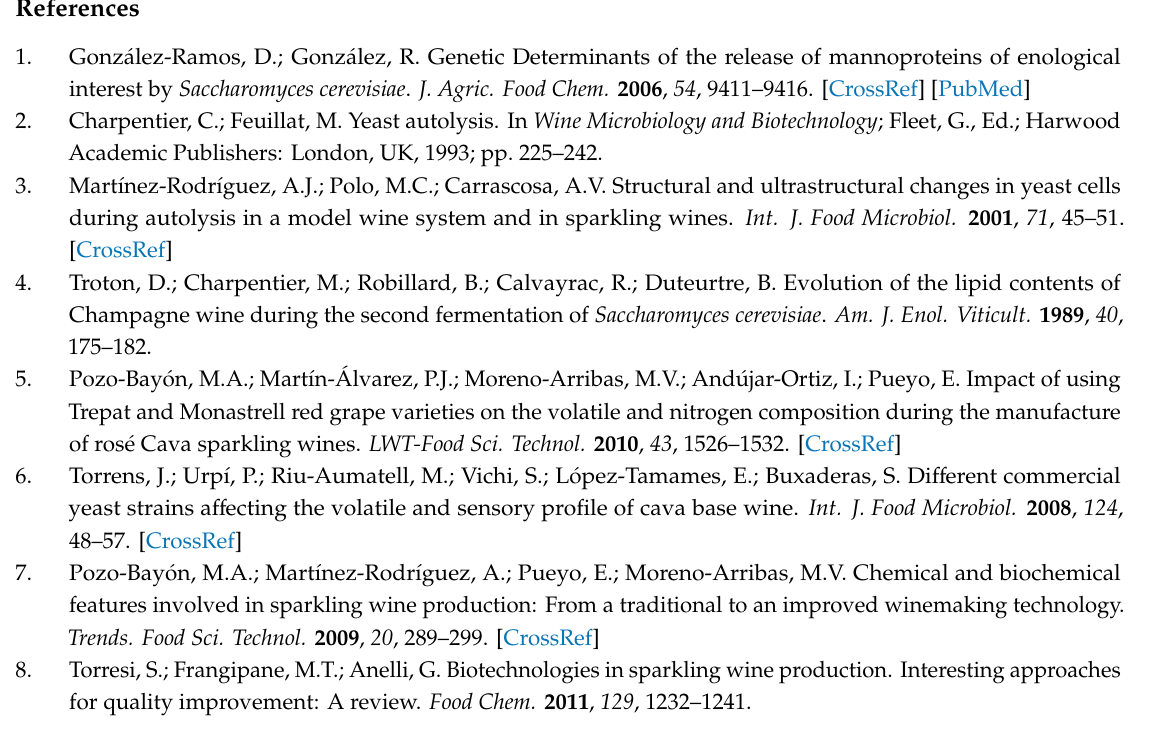
Table S1: Biological processes obtained in S. cerevisiae under conditions of second fermentation, Table S2: GO terms obtained in the middle of the second fermentation in S. cerevisiae , Table S3: GO terms obtained in the end of the second fermentation in S. cerevisiae